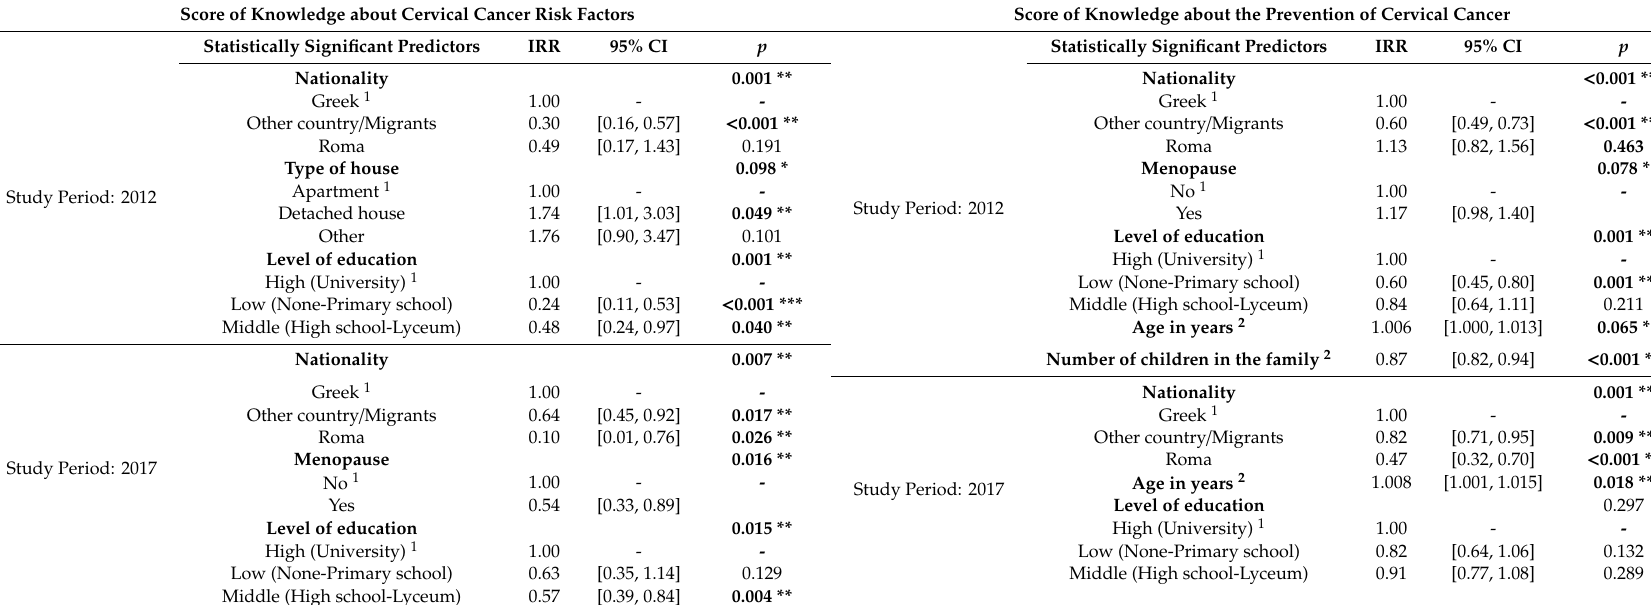
Table 5. Results from multivariate Poisson regression concerning the e ff ect of women’s characteristics on the average score regarding their knowledge about the cervical cancer and their knowledge about the prevention of cervical cancer, for each study period. Incidence Rate Ratio, 95% Confidence Intervals and the corresponding level of statistical